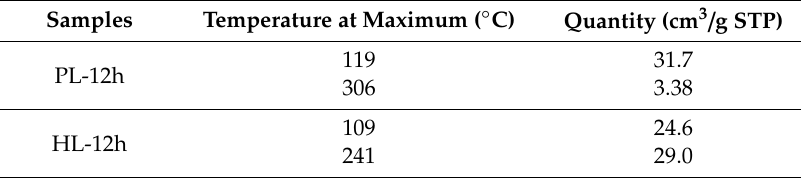
Table 1. The peak intensities quantified in the CO 2 -TPD